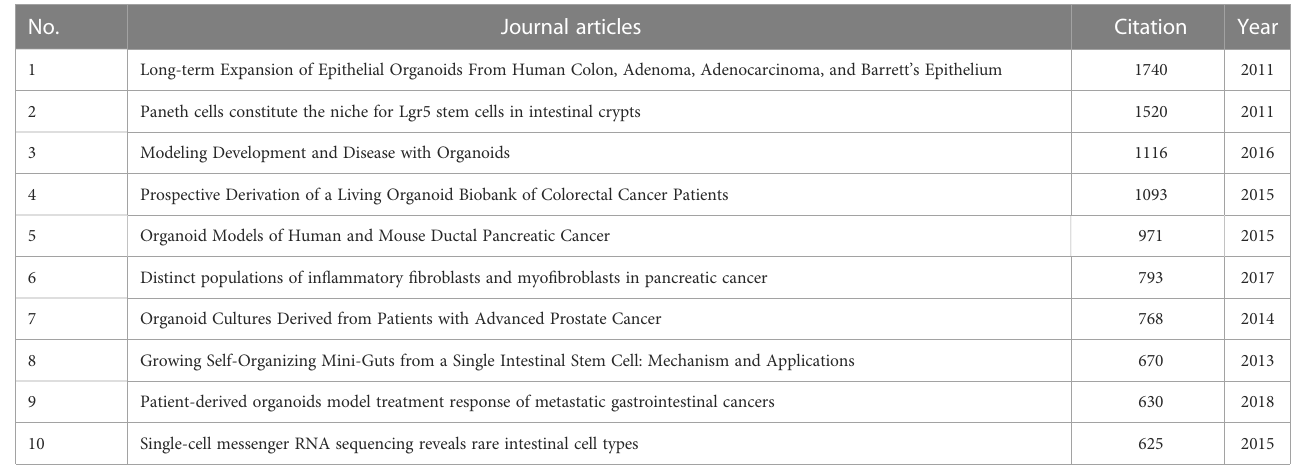
TABLE 6 The total number of citations of the top ten journal articles related to tumor